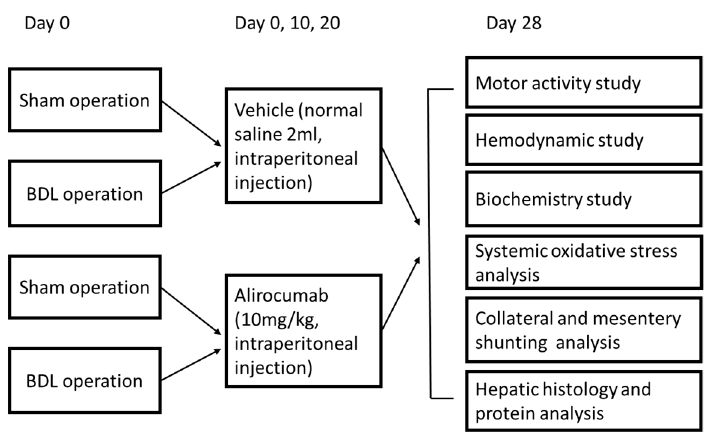
Figure 1. Study design of alirocumab-treated bile duct ligation (BDL) or sham-operated rats.